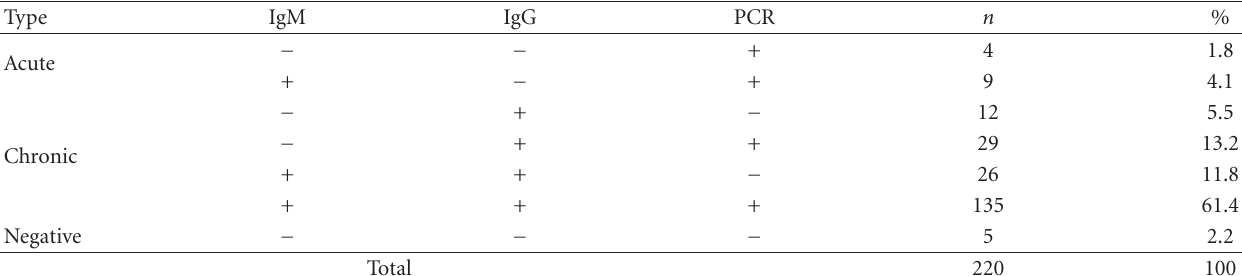
Table 1: Type and frequency of T. gondii infection in cats according to serological and molecular results.